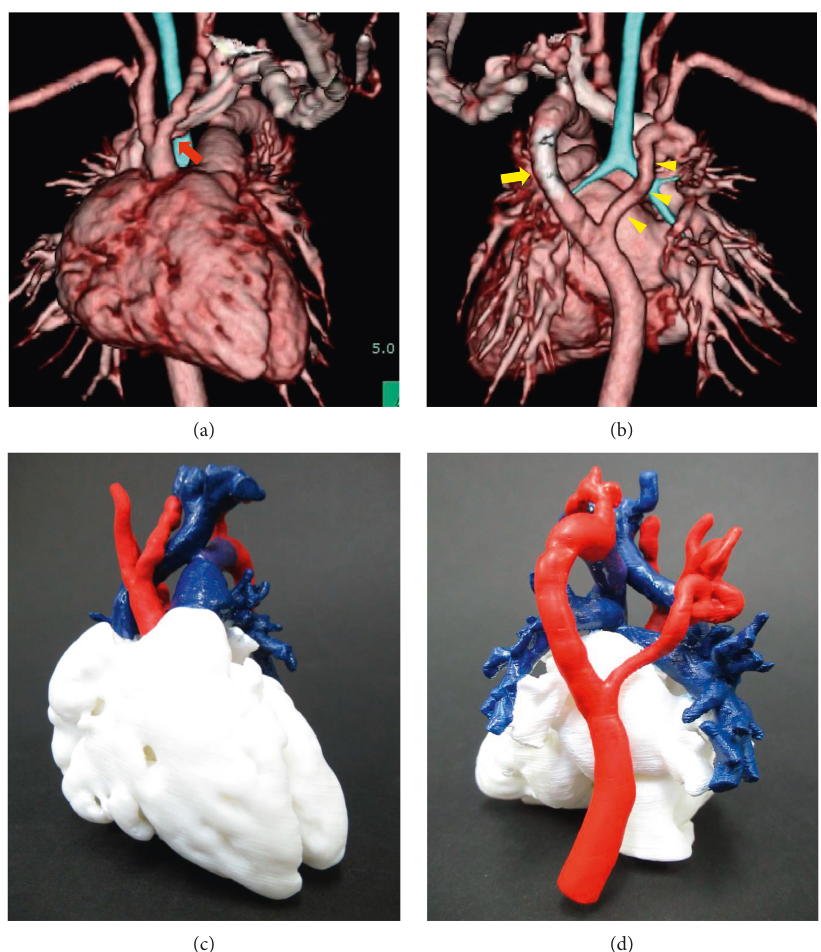
Figure 1: (a, b) Contrast-enhanced three-dimensional computed tomography images obtained at 8 days of age. (c, d) Patient-specific three- dimensional solid cardiovascular model based on computed tomography data at 8 days of age. Computed tomography scans were not electrocardiography-gated. (a) The frontal view. The left aortic arch was interrupted after the branching of the left common carotid artery (red arrow). (b) The rear view. This image shows the left distal arch connected to the ductus arteriosus (yellow arrow) and right distal arch (small yellow arrowheads). The right dorsal aorta was long and tortuous, with hemodynamic aortic coarctation. (c) The frontal view and (d) the rear view. Arteries are colored in red. Pulmonary arteries and veins are colored in blue. The patent ductus arteriosus is colored purple. The heart and vessel model was helpful to plan and simulate